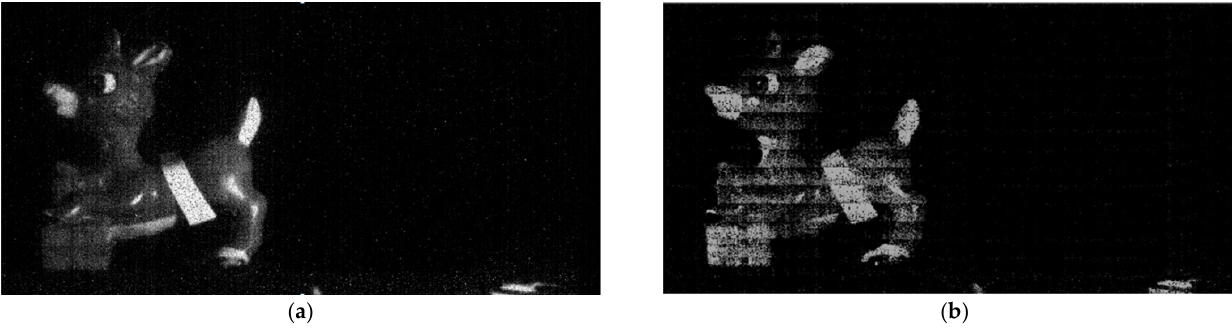
Figure 15. Sample image acquired with 0.5 e- threshold, ( a ) 230 fps and ( b ) 500 fps.